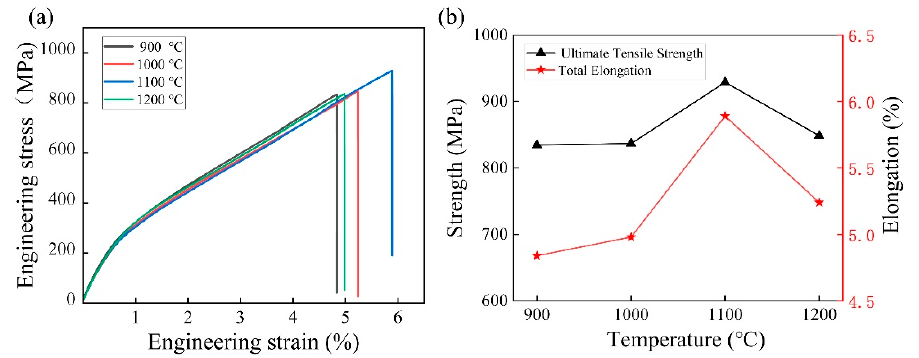
Figure 5. ( a ) Engineering stress–strain curve; ( b ) relationship between mechanical properties and solution temperature.